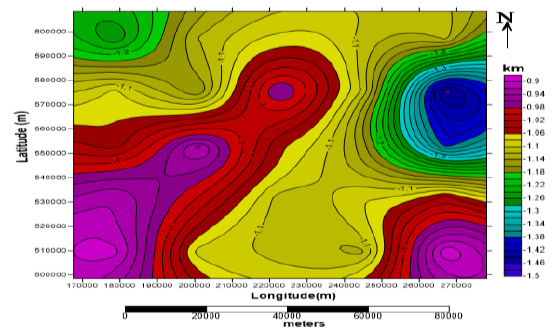
Figure 9: Deep depth to basement map.